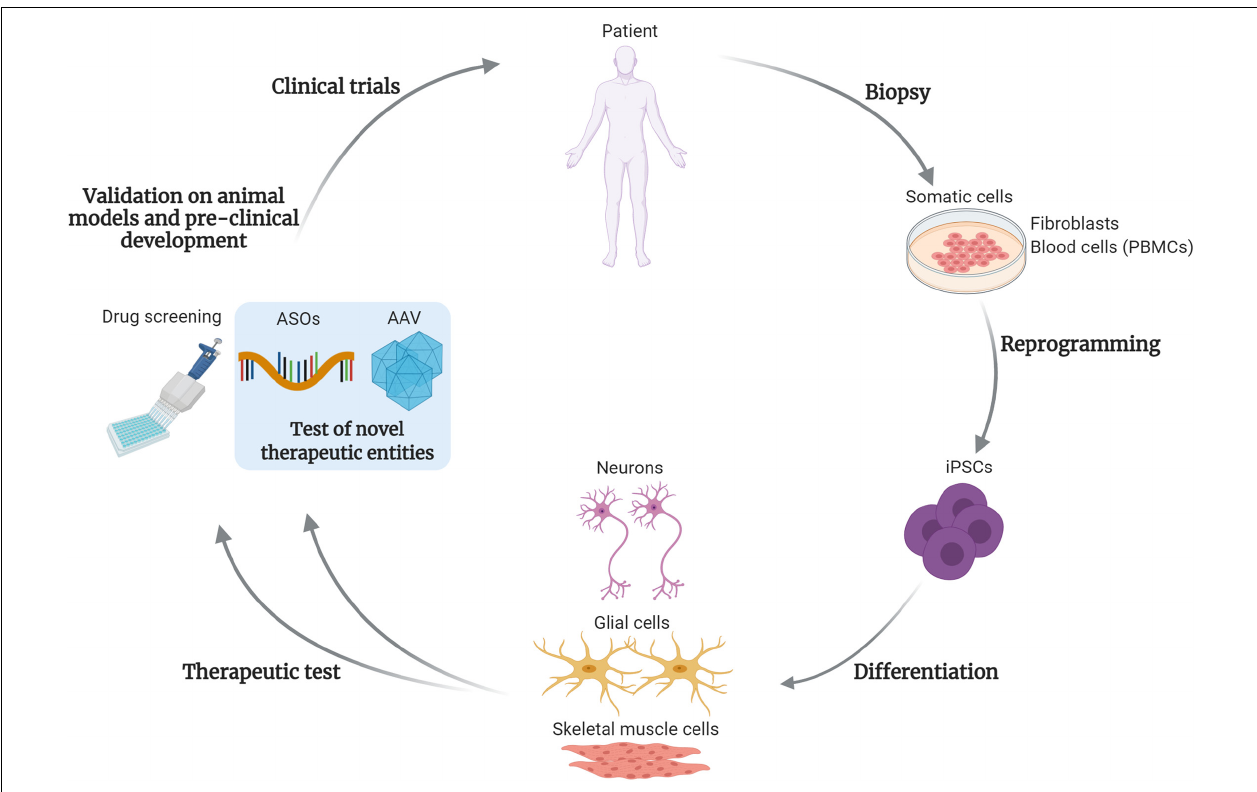
FIGURE 1 | Test and development of gene targeting approaches using iPSCs. This drawing summarizes the steps of development for drugs and gene therapy approaches, using induced pluripotent stem cells (iPSCs). Somatic cells, such as fibroblasts or blood cells (peripheral blood mononuclear cells, PBMCs) are obtained from patient’s biopsies. After reprogramming, the patient-derived iPSCs can be differentiated into disease-relevant cell types, such as skeletal muscle cells, neural or glial cells for neuromuscular or motor neuron disorders. These cells are then subjected to the classical high-throughput drug screening and in perspective will be used to test novel therapeutic entities, based on gene targeting approaches. As example, antisense oligonucleotides (ASOs) or adeno-associated viral vectors (AAV)-based strategies. After validations in animal models and the pre-clinical development process, these novel therapies could enter into clinical trials for patients affected by rare disorders. The use of iPSCs and gene targeting strategies will likely foster the development of personalized medicine approaches. Created with